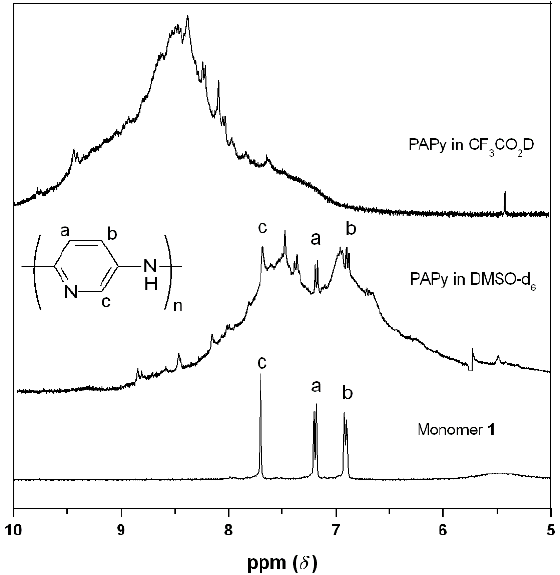
Figure 2. 1 H NMR spectra of the aromatic region of monomer 1 and PAPy (degree of polymerization ( DP ) = 18) at 400 MHz. DMSO-d6 was used as solvent for monomer 1 and PAPy spectra. Deuterated trifluoroacetic acid was also used as solvent for PAPy spectra (upper view).